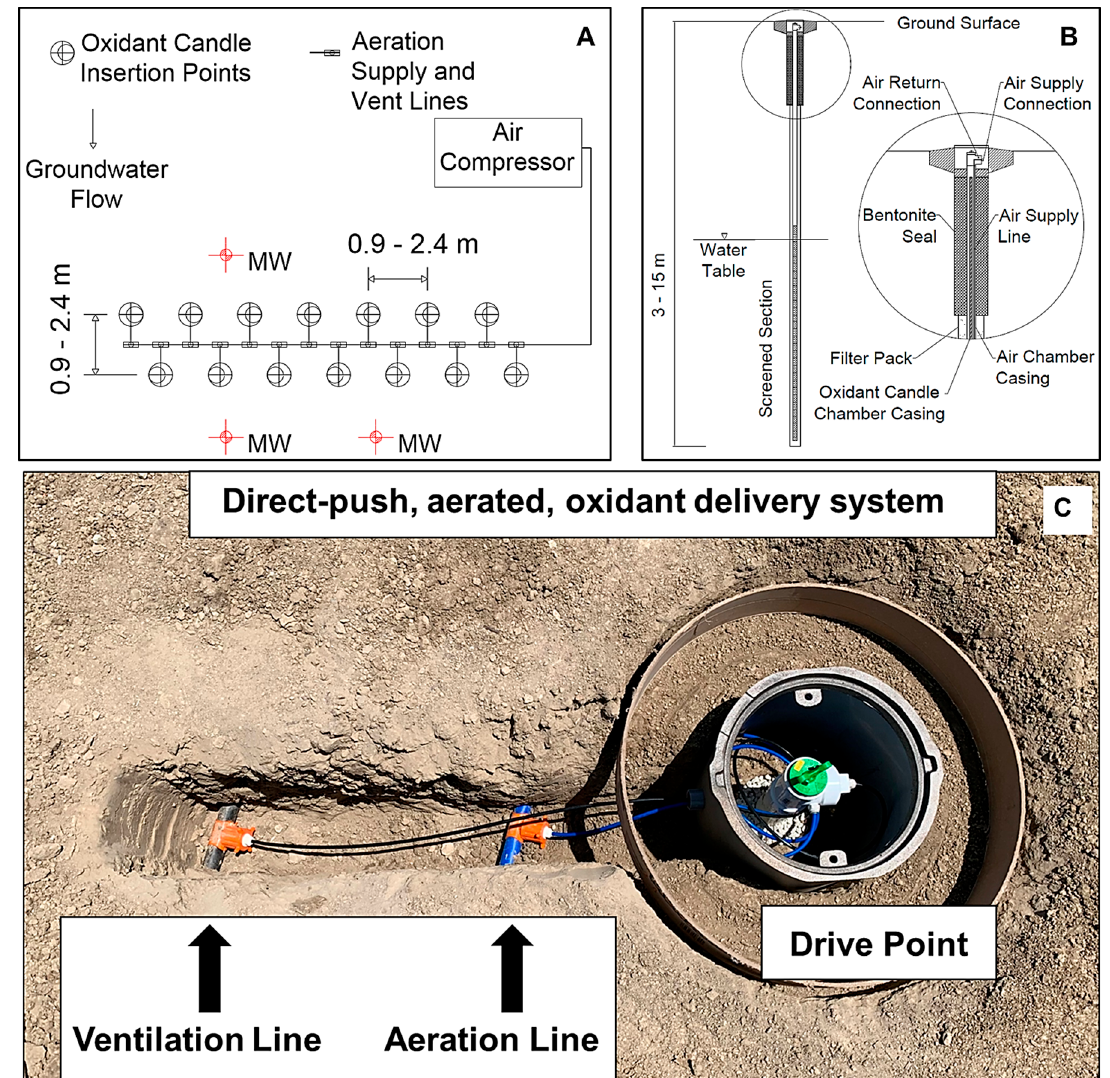
Figure 1. ( A ) Generic plot plan (plan view); ( B ) vertical view of drive points used in deploying the direct-push, aerated, oxidant delivery system and ( C ) photograph of direct-push, aerated, oxidant delivery system.